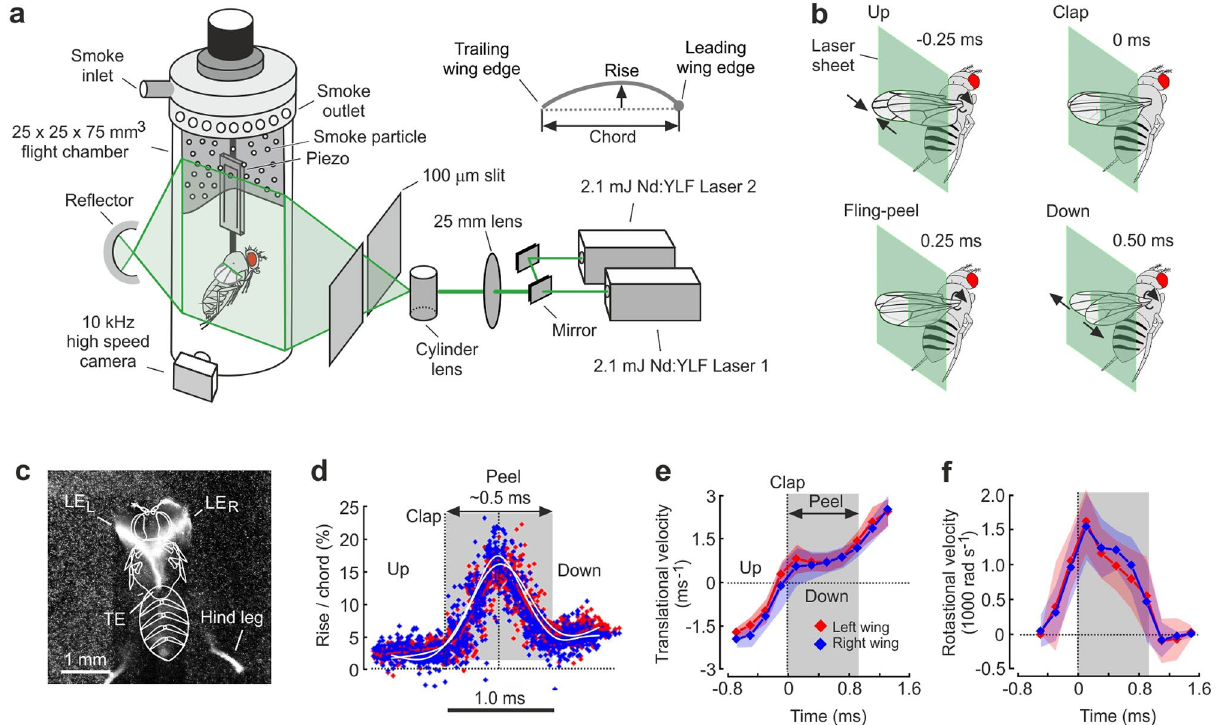
Figure 1. Experimental setup, wing kinematics and elastic wing deformation during the dorsal stroke reversal. (a ) A single fly is tethered to a 100 µm tungsten wire and flown in a 25 × 25 × 75 mm 3 flight chamber. The wire is attached to a piezo element recording an electrical signal synchronous to wing flapping motion. The signal triggers a high-speed video camera equipped with magnifying lenses and a teleconverter. A Nd:YLF dual laser generates a ~ 500 µm thin light sheet for flow measurements by time-resolved particle image velocimetry. Flow vectors are calculated from adaptive cross-correlation and smoothed by a spatial filter with 160 × 160 image pixels. The laser light is guided through a 25 mm beam waist adjuster and a cylinder lens, and narrowed by a ~ 100 µm mechanical slit. Smoke from burning plant debris is pumped as seeding particles into the chamber at low speed. Inset shows schematics of the wing’s rise-to-chord ratio as plotted in d. Drawing is not to scale. ( b ) Four significant phases of wing motion during dorsal wing-wing interaction in the fruit fly. At the stroke reversal, leading edges of left and right wing touch (up) while the wings rotate about their longitudinal axes. After wing clapping (clap), the wings chordwise bend (peel), forming an opening cleft (fling) at the leading edge while the trailing edges remain connected. The wings separate ~ 500 µs after wing clapping, starting the downstroke (down). ( c ) Top view image of left and right wing chord of Drosophila virilis during the fling phase, highlighted by a laser at 0.6 wing length. Body outline is superimposed. View is on the dorsal body side and from wing tip to hinge. ( d ) Change in chordwise wing bending (rise-to-chord). Left (red) and right (blue) wings are maximally deformed ~ 300 µs after wing clapping. White lines are filtered means. ( e ) Mean translational and ( f ) mean rotational wing velocity about the wing’s longitudinal axis measured at 0.6 wing length of left (red) and right (blue) wing during the dorsal reversal. Corresponding coloured areas indicate standard deviations. Data are from 12 animals and 15 stroke cycles. Grey areas show wing peel